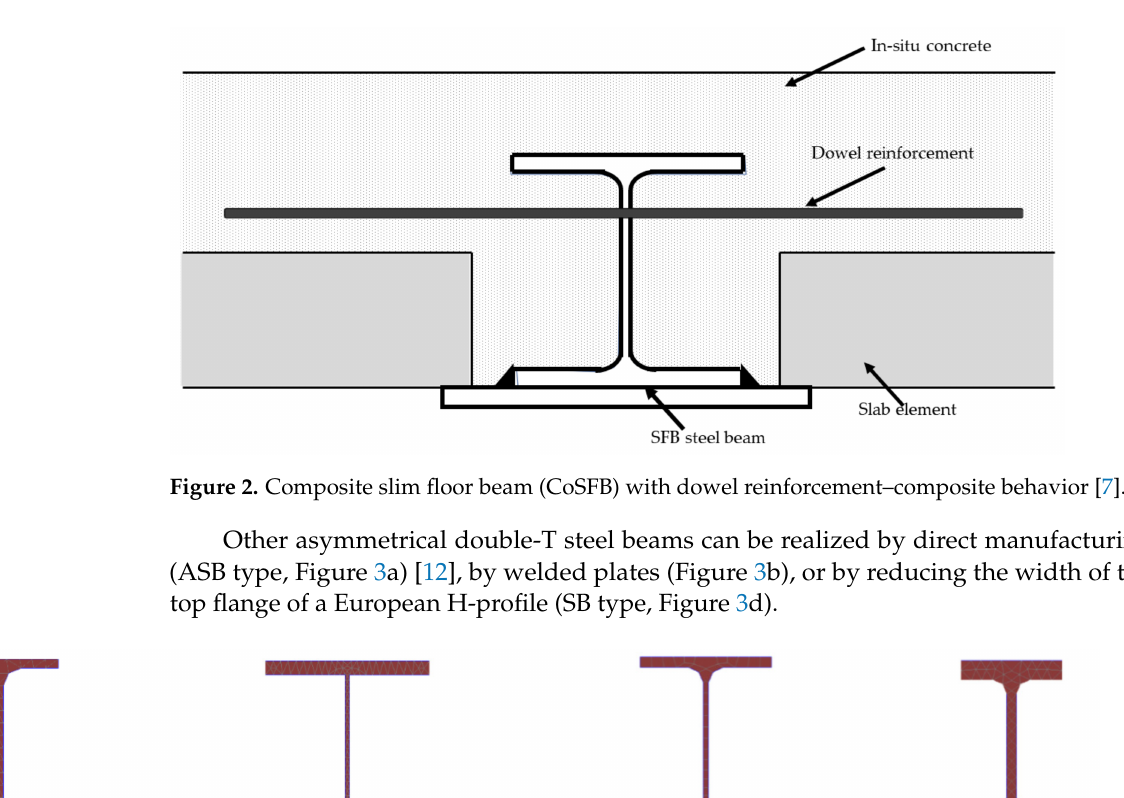
Figure 1. Asymmetrical slim floor beam: ( a ) with a wider plate welded below the bottom flange slim floor beam (SFB); ( b ) with a wider bottom flange integrated floor beam (IFB) [7].